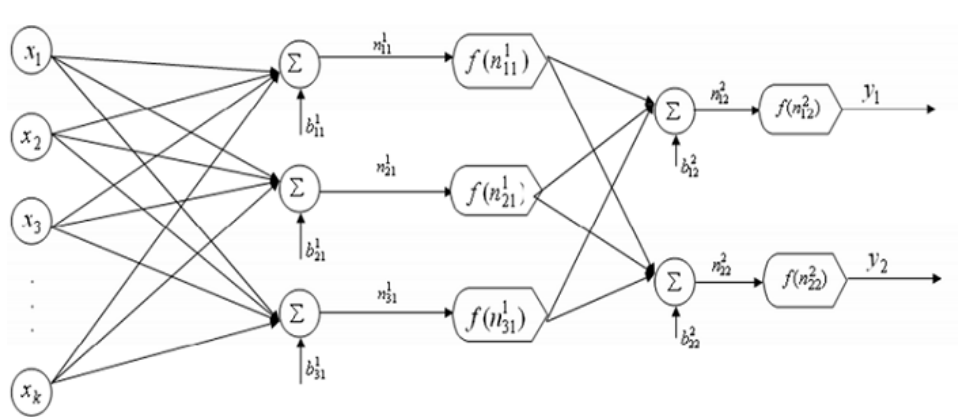
Figure 2. MLP network with a hidden